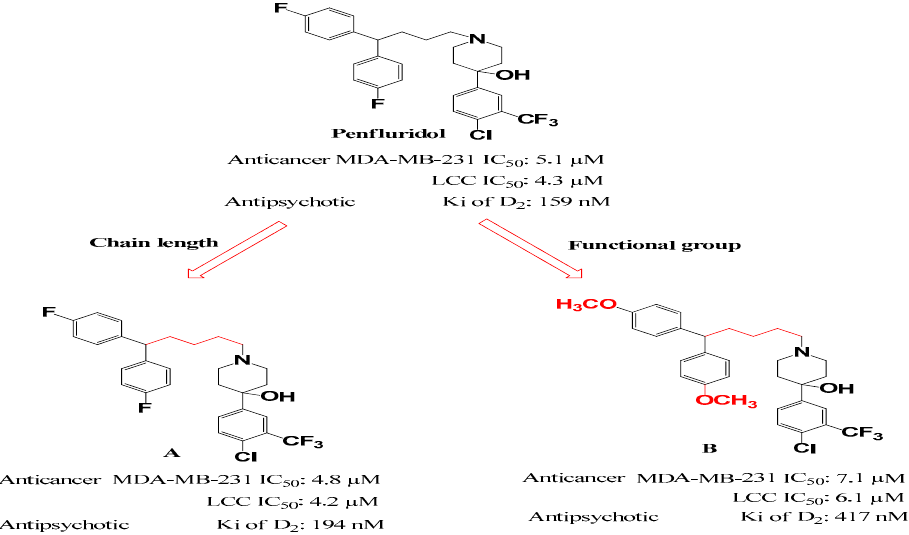
Figure 4. Two synthesized analogs ( A and B ) of penfluridol and penfluridol with the anticancer effect against MDA-MB-231 and Lewis Lung Carcinoma (LLC) cell lines and antipsychotic effects Ki of D2 receptor. Modified from Ashraf-Uz-Zaman’s report [9].